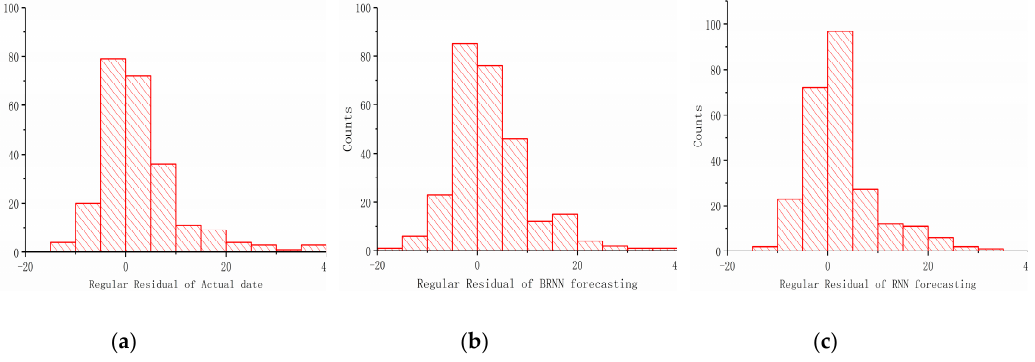
Figure 14. This is a histogram of regular residual of traffic flow prediction results. Graph ( a ) is a histogram regular residual of the actual data. Graph ( b ) is a histogram regular residual of the BRNN model. Graph ( c ) is a histogram regular residual of the RNN model.